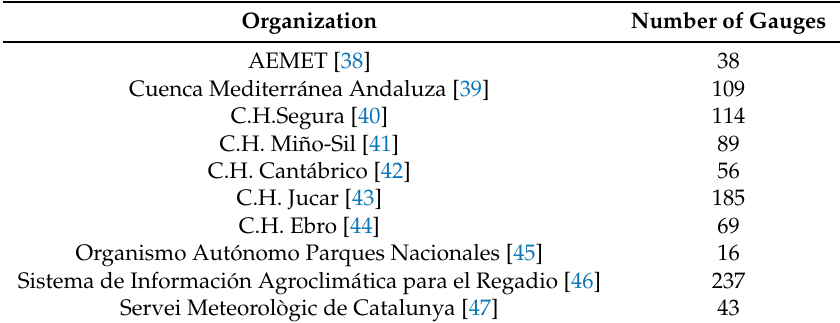
Table 1. Organizations providing rainfall data for the